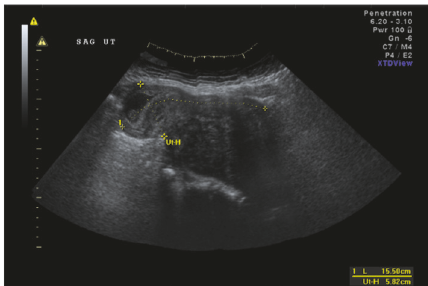
Figure 3: US image of fibroid uterus 6 weeks after treatment. intramuscular methotrexate for first-trimester termination of pregnancy complicated by massive fibroid